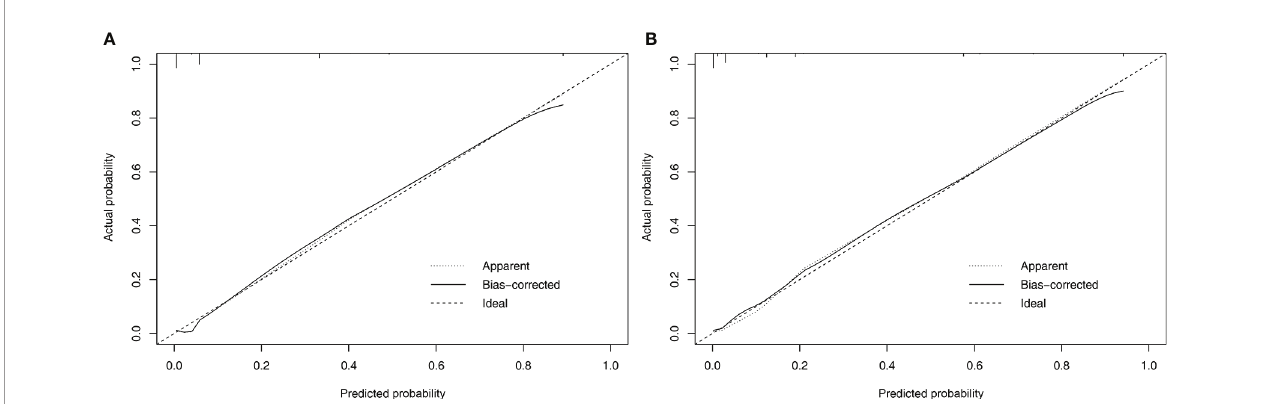
FIGURE 5 | Calibration plots comparing predicted and observed probabilities for extranodal nature killer/T-cell lymphoma-associated hemophagocytic syndrome in all patients (A) and patients with available Epstein-Barr virus DNA data